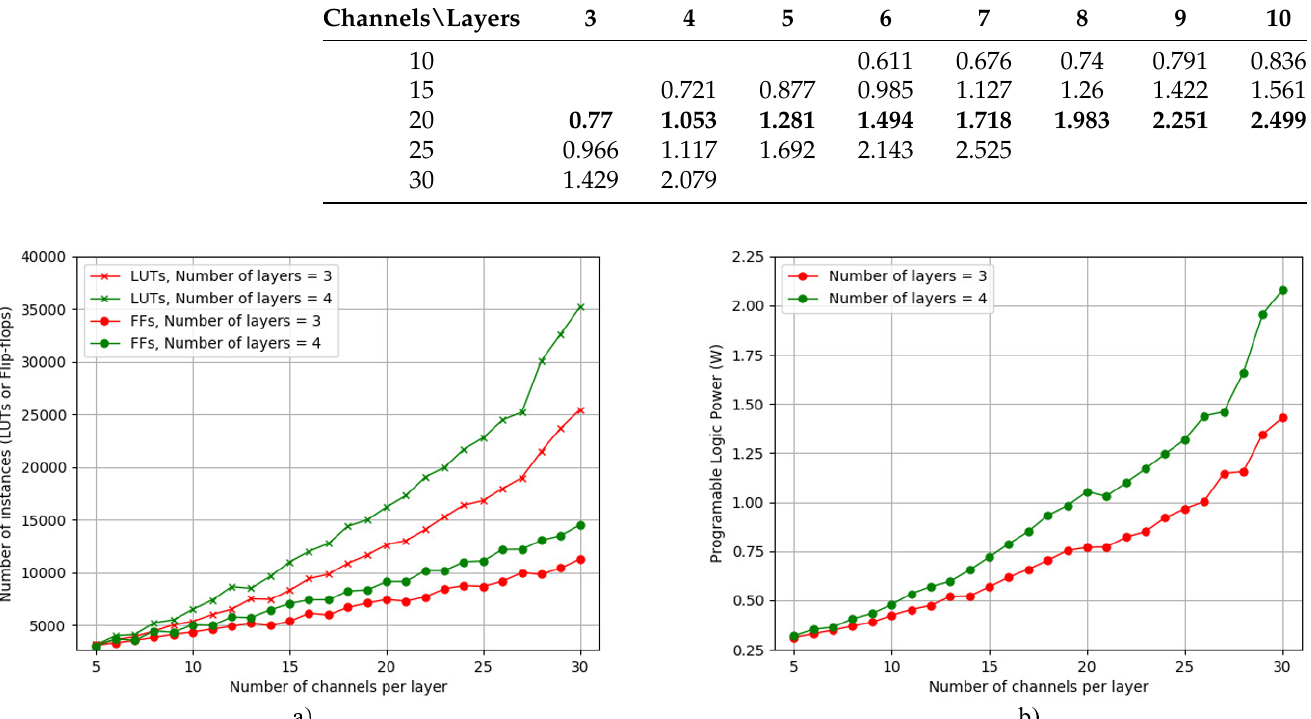
Figure 5. The hardware and power cost estimation for a list of BNN models with different L and C values on FPGA: ( a ) hardware resources for BNN models with different L and C values on FPGA; ( b ) power consumption for BNN models with different L and C values on